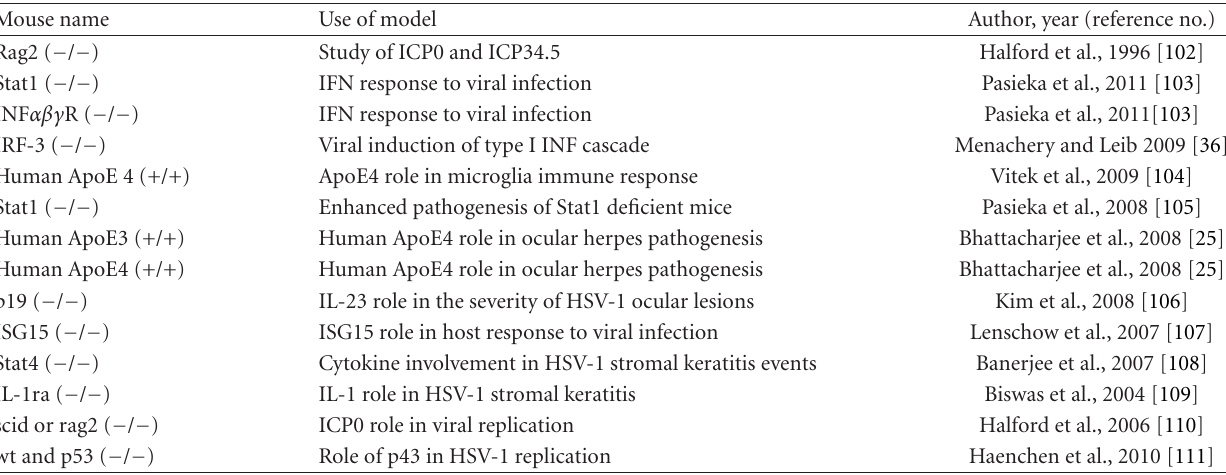
Table 1: Selected transgenic mice used for the study of ocular HSV-1.